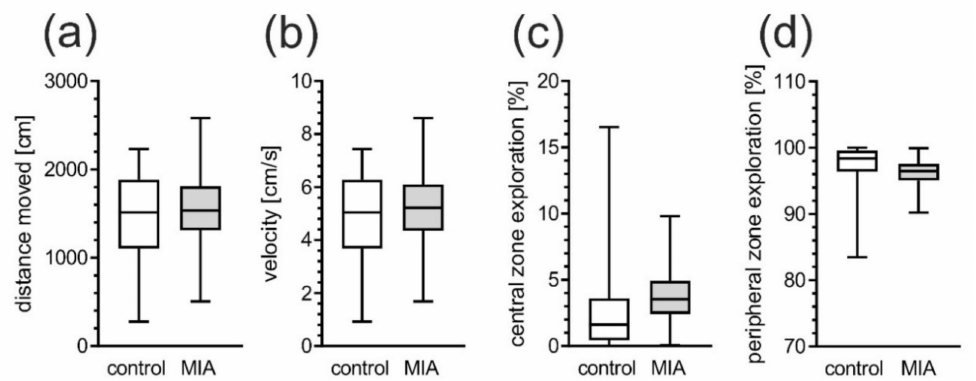
Figure 2. MIA does not a ff ect exploration of open field (OF) in adolescent rats. E ff ects of MIA on general locomotor activity and anxiety were measured in open field test in PND 40 male rats. The locomotion behavior was analyzed by measuring total traveled distance ( a ) and velocity ( b ) of MIA animals and saline-treated controls. The anxiety-related behavior was examined by measurement of central ( c ) and peripheral ( d ) zone exploration of MIA animals and controls. n = 28 and 34 in control group and in MIA group, respectively. Data represent medians with interquartile range, minimum, and maximum.